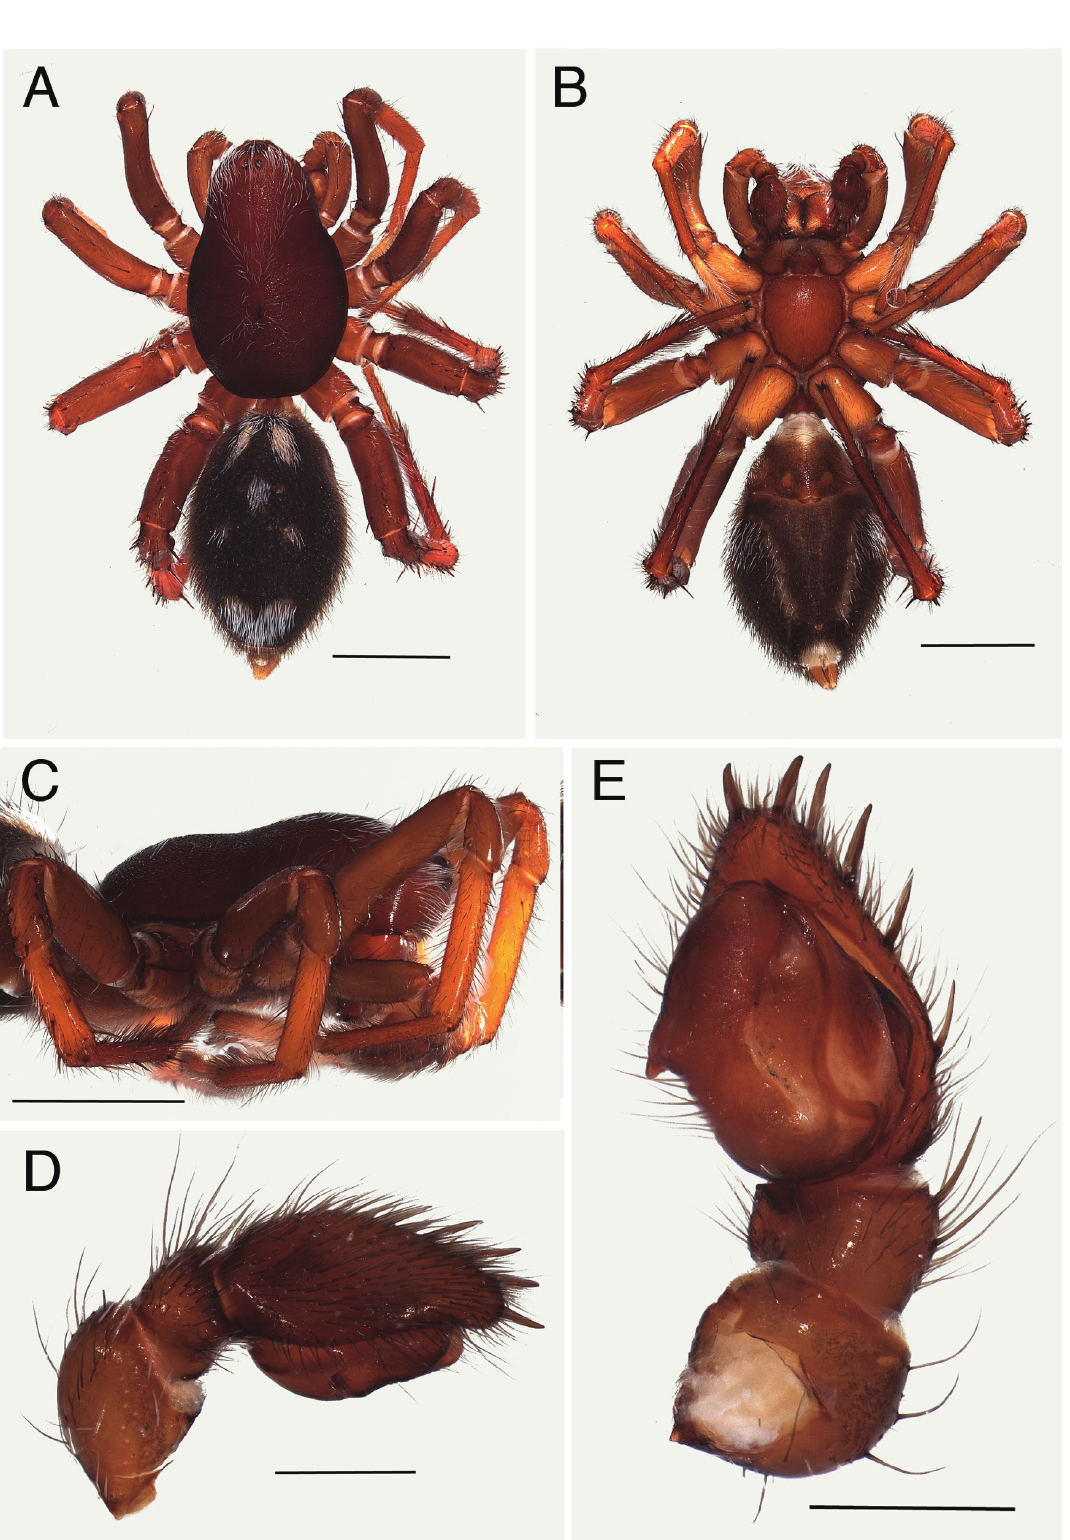
Fig. 14. Palindroma sinis gen. et sp. nov., holotype, ♂. A . Habitus, dorsal view. B . Idem, ventral view. C . Idem, lateral view. D . Palp, retrolateral view. E . Idem, ventral view. Scale bars: A–c = 2 mm, d–e = 0.5